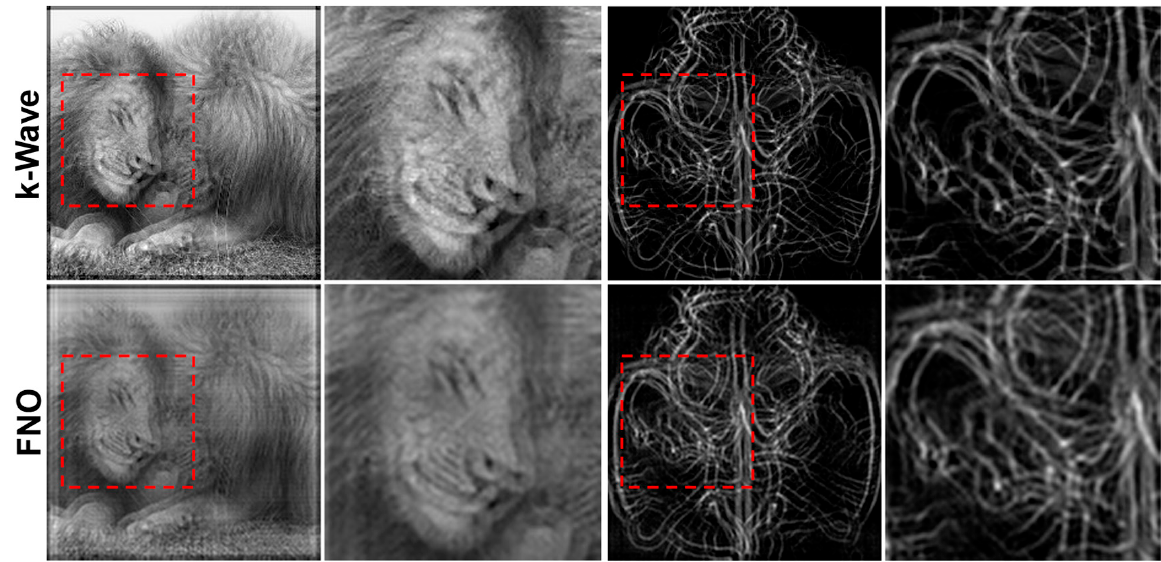
Figure 11. Zero-shot super resolution using an FNO trained on a 128 × 128 × 302 computational grid to perform simulations on a 224 × 224 × 302 grid. Images from the FNO and k-Wave simulations at t = 5 and zoomed regions are shown. ( Left ) Animal image of a lion from the testing dataset. ( Right ) Vasculature image to evaluate FNO